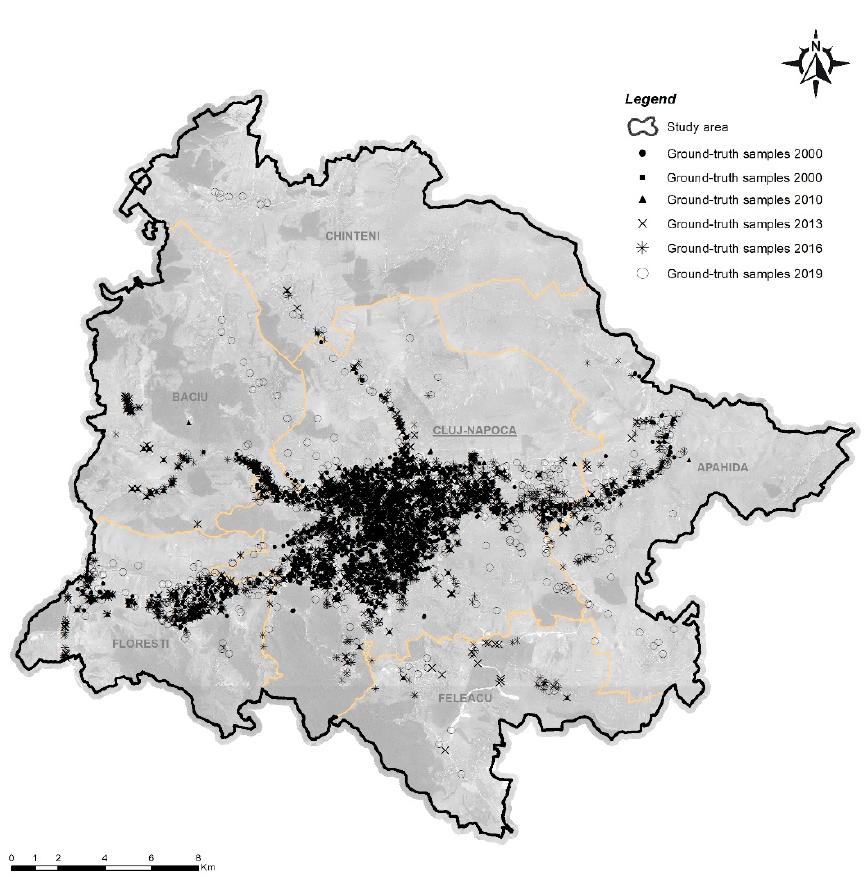
Figure 5. Ground-truth sample points used for validation and accuracy assessment. Table 4. Accuracy assessment and validation by method number